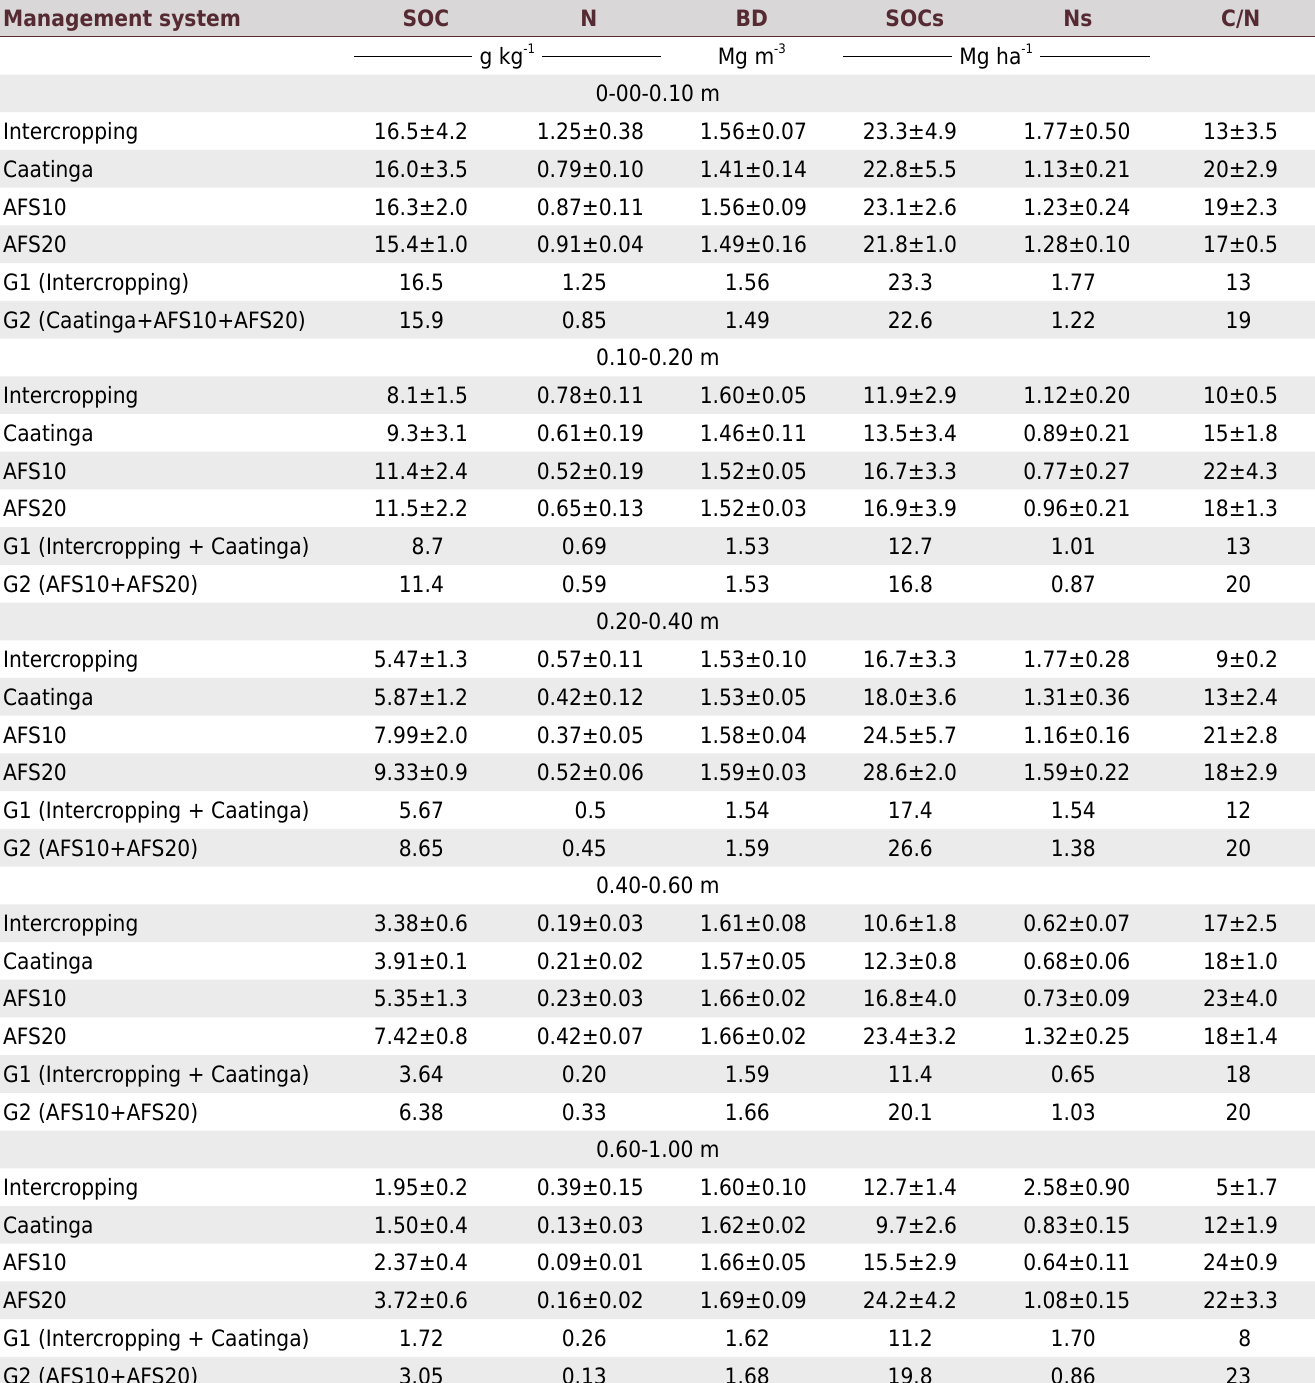
Table 1. Mean and confidential interval (p<0.05) of carbon (SOC) and nitrogen (N) contents, soil bulk density (BD), stock (SOCs and Ns), and C/N ratio under the managements Intercropping, Caatinga and agroforestry systems (AFS10 and AFS20), and groups of clusters analysis for the evaluated soil layers Management